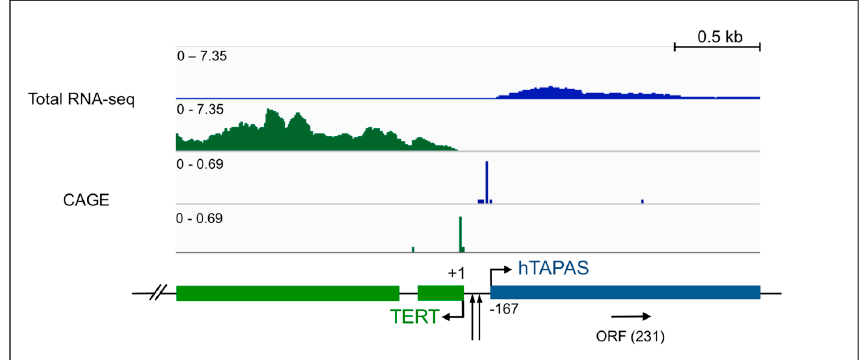
Figure 1. An antisense RNA, named human TAPAS RNA, is expressed in the human telomerase reverse transcriptase ( hTERT ) promoter region. Normalized and stranded RNA sequencing (RNA ‐ seq) (Bedgraph) transcription coverage for hTERT (green) and hTAPAS (blue) expression, as well as corresponding cap analysis gene expression (CAGE) start sites, are depicted for the human B ‐ cell line GM12878. The schematic below denotes Reverse Transcription PCR (RT ‐ PCR) validation of hTAPAS transcript from human embryonic kidney (HEK ‐ 293) cells by tiling arrays. The first two exons of hTERT and an approximately 1.6 kb long hTAPAS gene, located 167 nts upstream of the hTERT transcriptional start site are depicted. Arrowheads between hTERT and hTAPAS represent sites of point mutations in the hTERT promoter, located 124 or 146 nucleotides upstream of the hTERT translational start site.